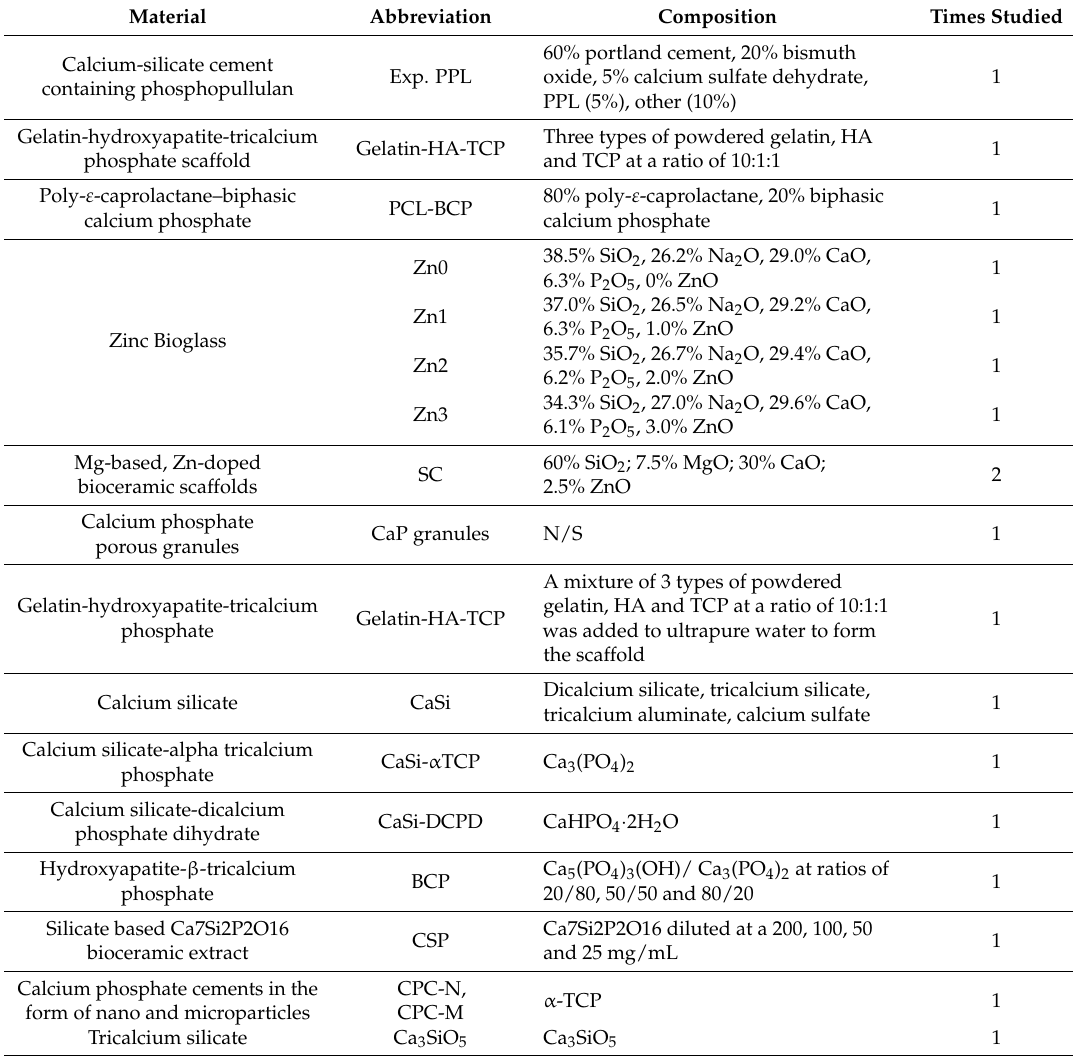
Table 3. List of experimental/novel bioceramic materials